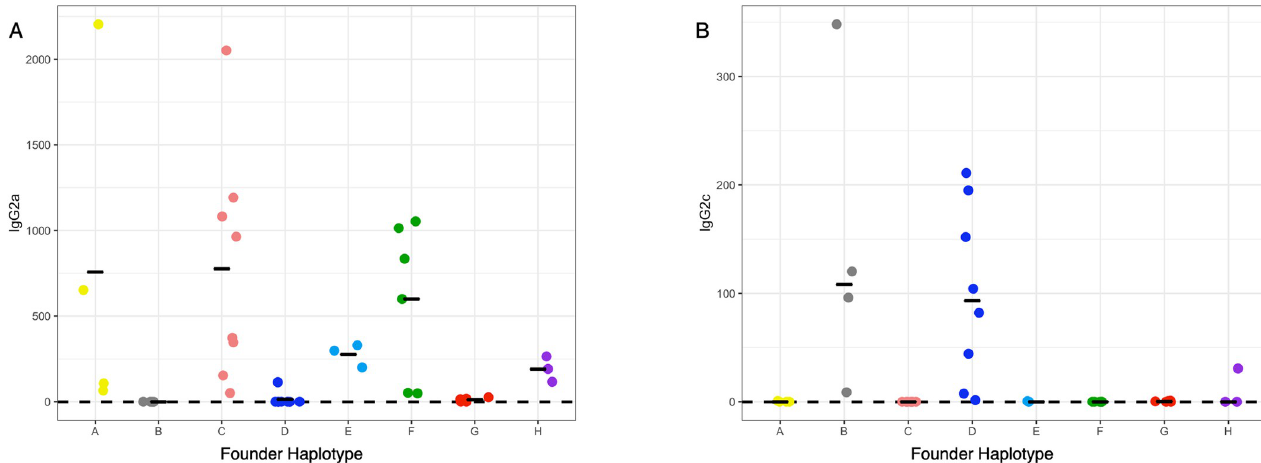
Fig 2. Expression of IgG2a and IgG2c by founder strain haplotype at the heavy chain locus. The mean value for IgG2a and IgG2c concentration (ug/mL) was determine for each CC strain. Mean values were plotted by the founder strain haplotype at the immunoglobulin heavy chain locus (Chromosome 12: 113 – 120Mb). Black bars indicate the mean concentration for a given founder haplotype and each individual point represents a strain with that founder haplotype at Igh . The y-axis is the concentration for IgG2a or IgG2c in ug/mL and the x-axis is the founder strain haplotype groups. Strains with undetectable concentrations of IgG2a or IgG2c were set to the lower limit of detection of the assay. Limit of detection represented by the dashed black